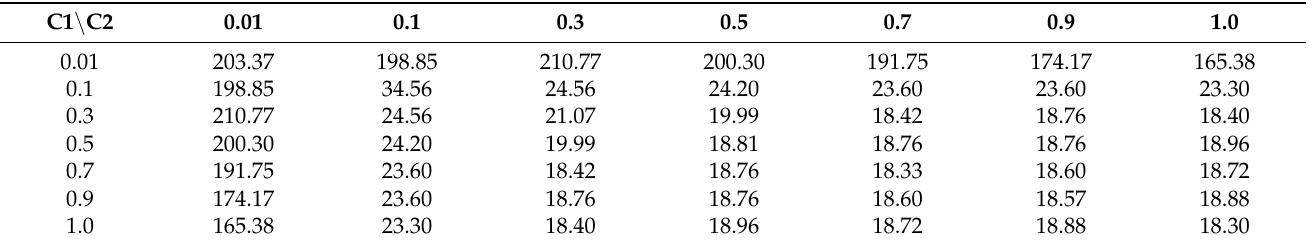
Table 4. The membrane impedance R m ( Ω cm 2 ) at electrolytes C1 and C2 (M) on both sides of the membrane, as measured by AC impedance